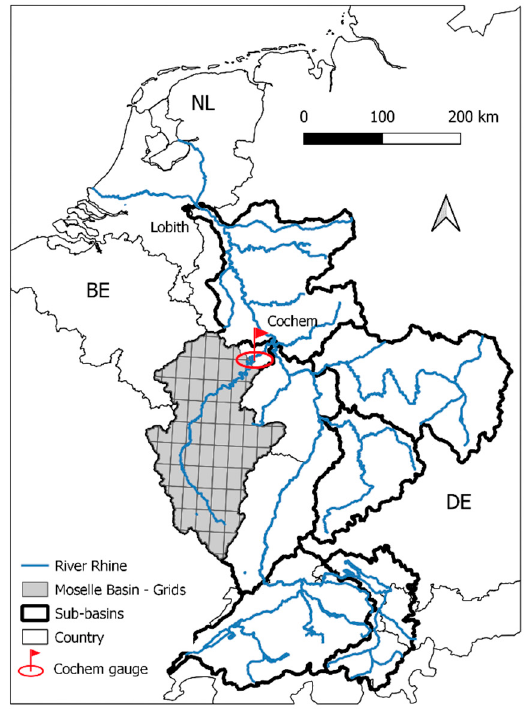
Figure 1. Moselle River Basin and Cochem Gauge.